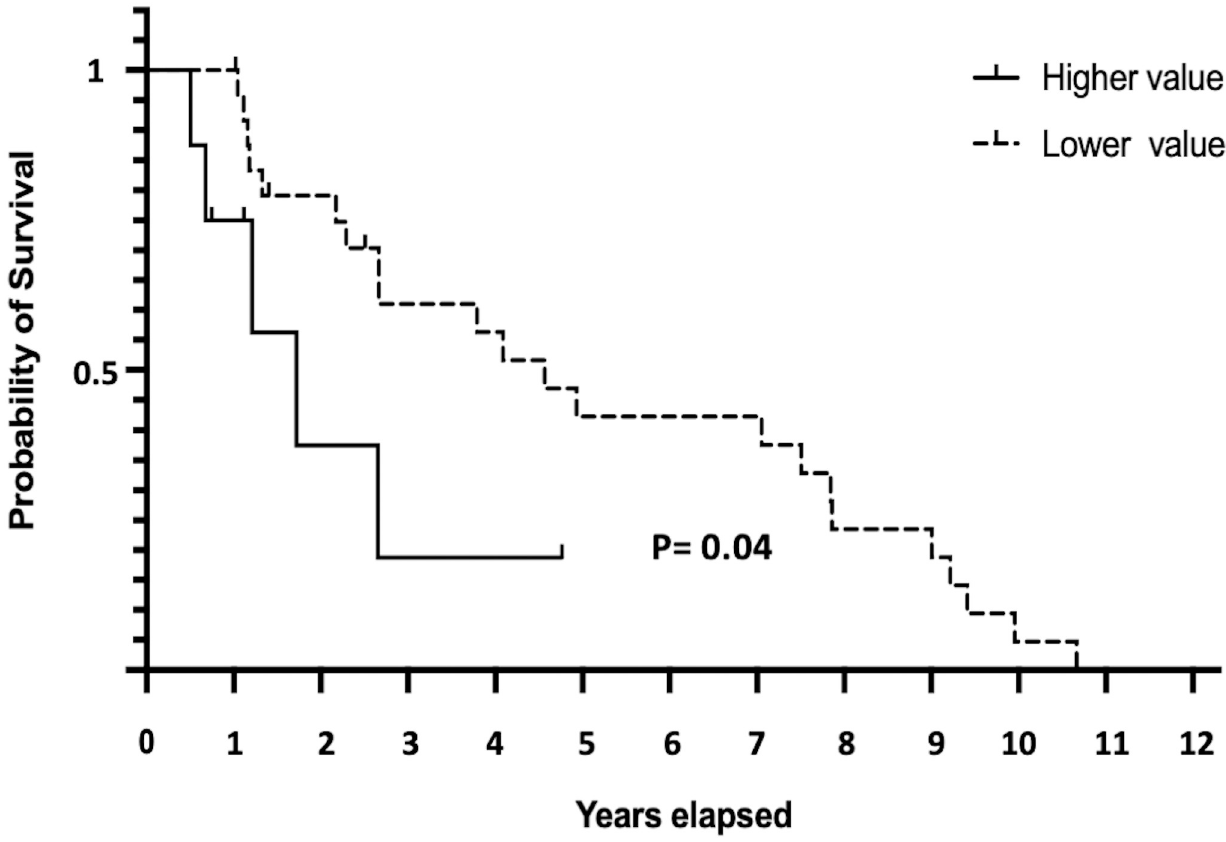
Fig 4. Comparison of survival in MB patients with different radiomics values. For tumors with Energy value > 0.23 or SRLGLE value > 0.08, patients have shorter survival time than tumor don’t have these features (p = 0.04 in Log-rank [Mantel-Cox] test).